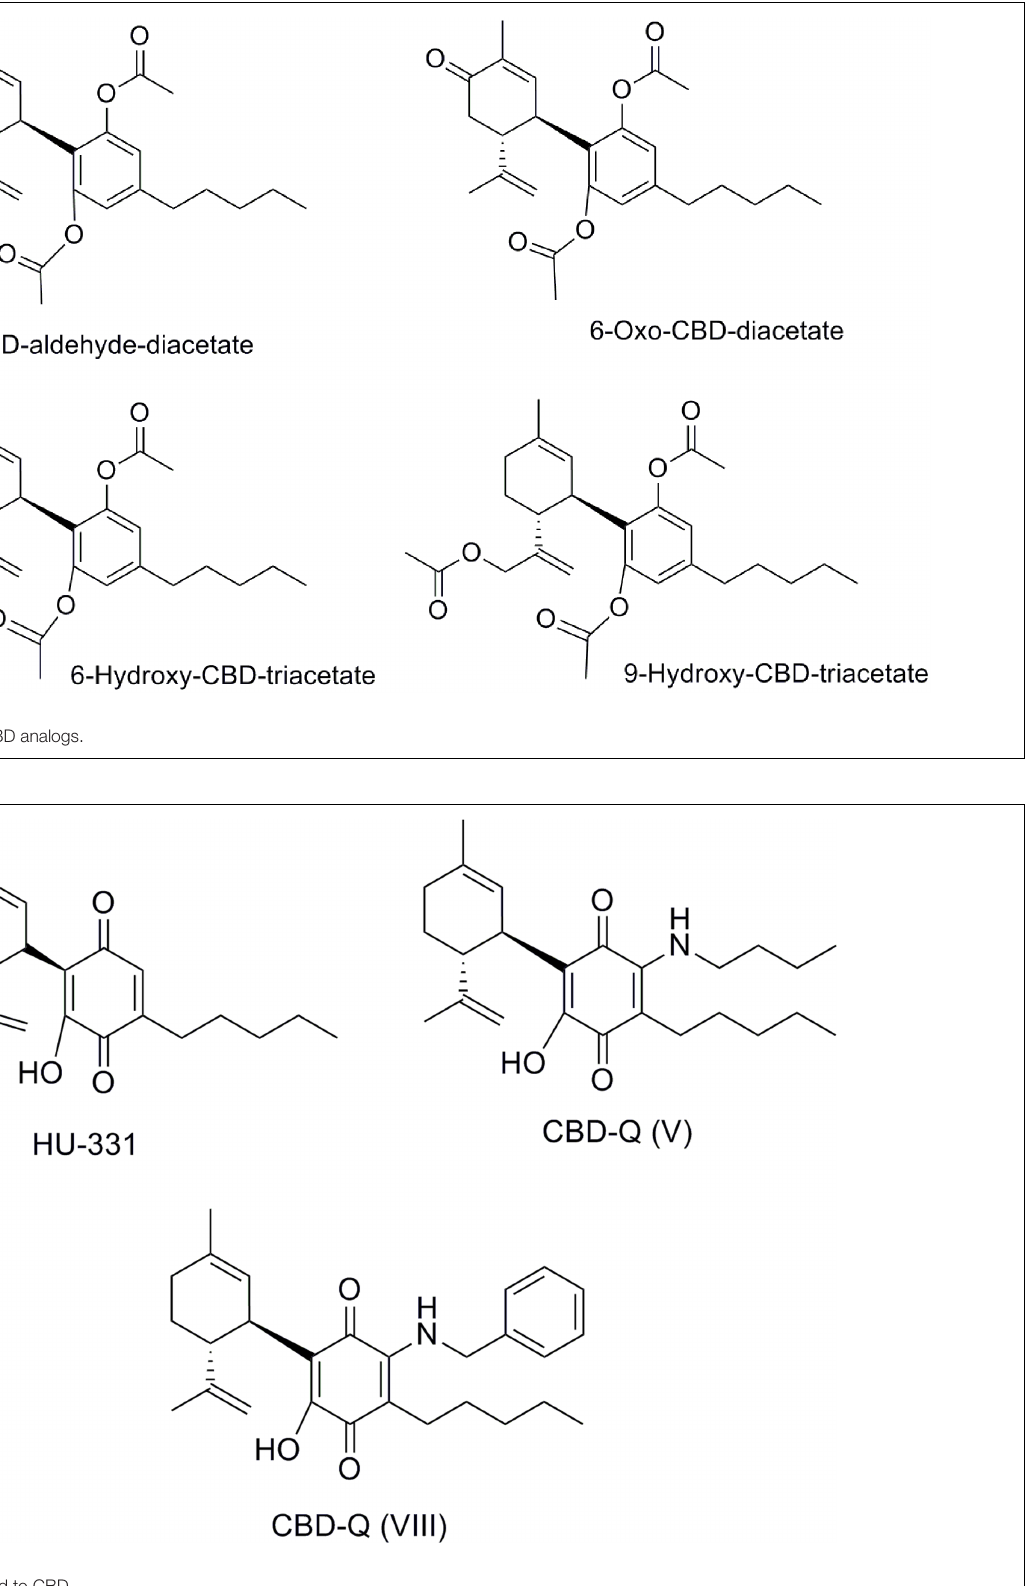
FIGURE 13 | Quinones related to